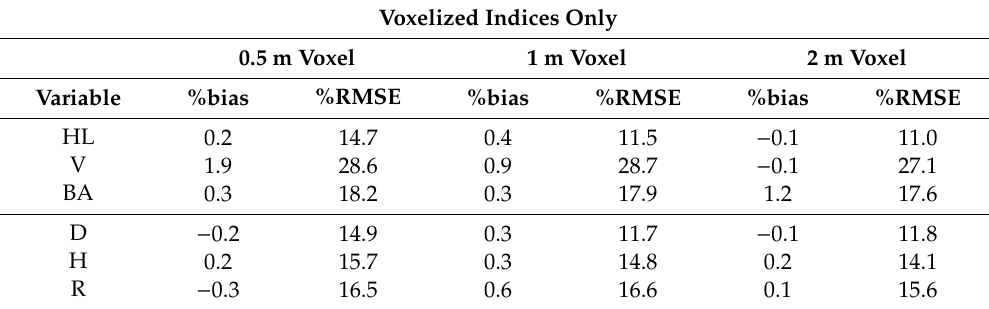
Table 10. %RMSE and %bias results for models trained using voxel vegetation indices at 0.5, 1, and 2 m resolutions.